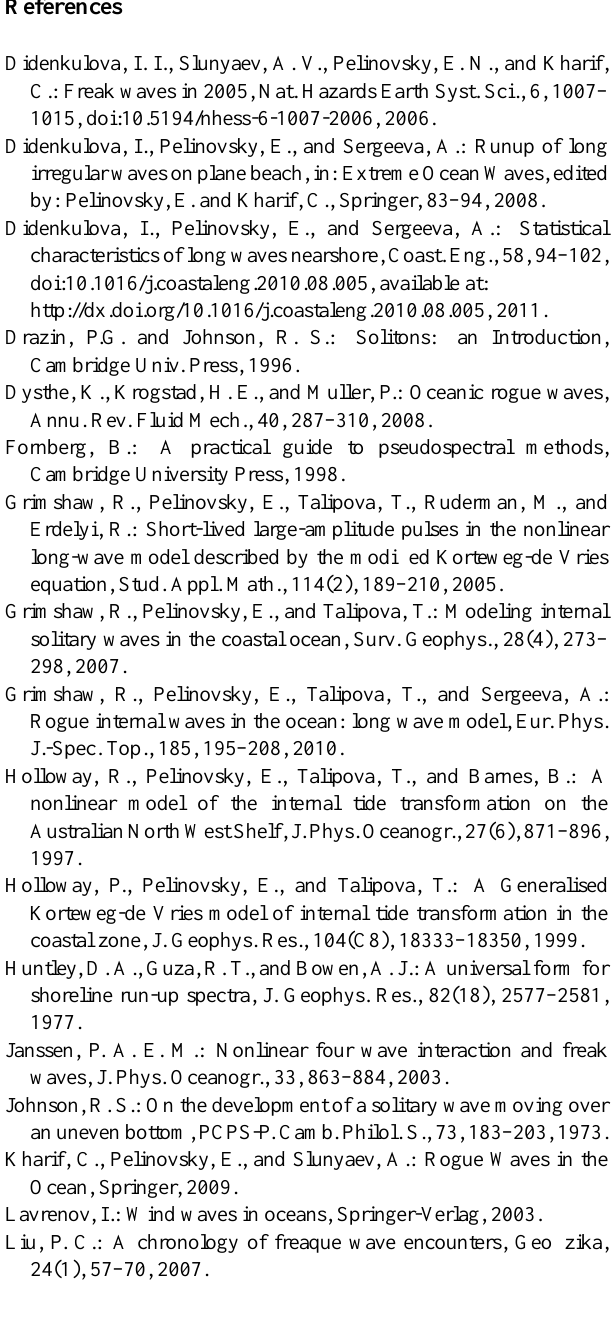
Figure 9. The exceedance probability distribution function of wave heights scaled by H s corresponded to h =5 m (blue symbols) and h =10 m (red